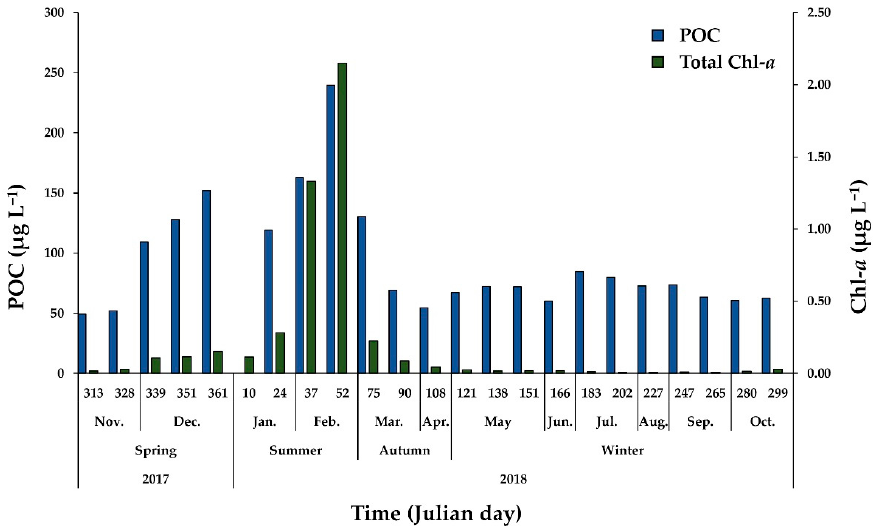
Figure 3. Variations in each major inorganic nutrient concentration at the JBS during our sampling period.